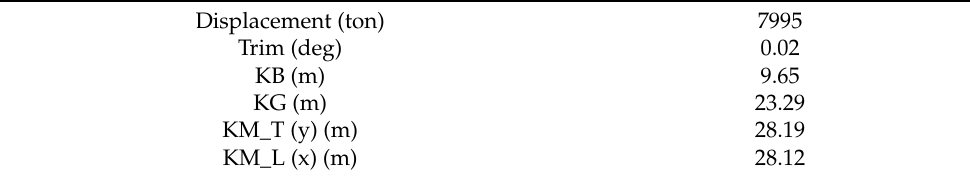
Table 3. Main hydrostatic parameters for the operating draft